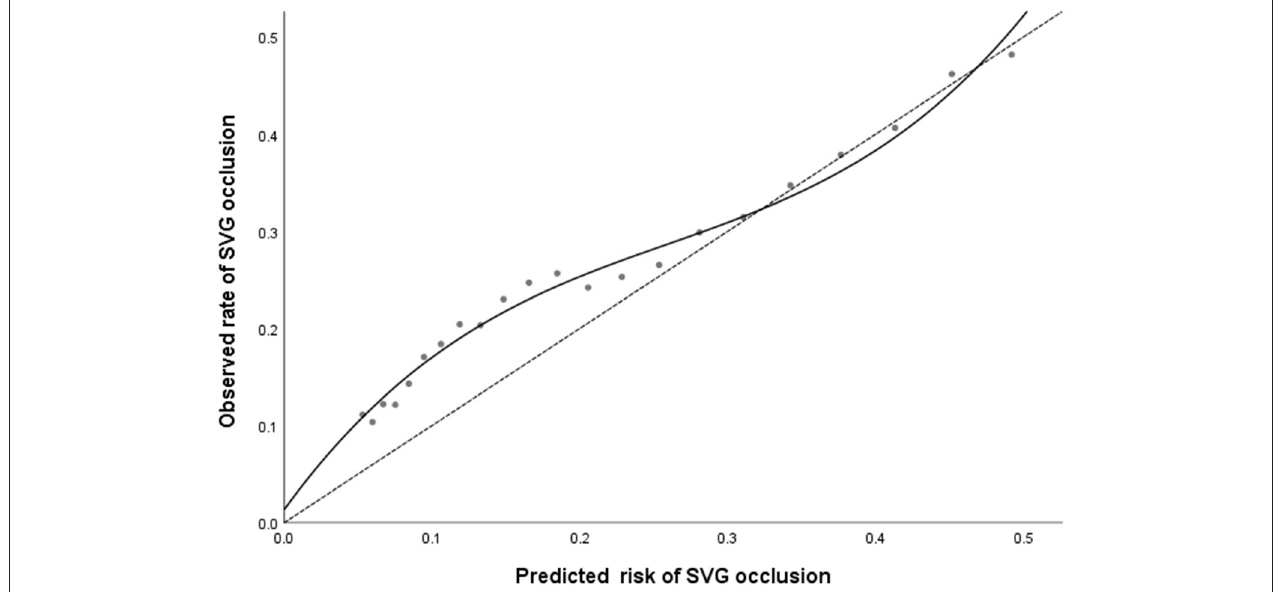
FIGURE 3 | The calibration plot presents the predicted risk against the observed proportion of late SVG occlusion for 21 groups based on the calculated SVG occlusion risk score. A locally weighted regression line is plotted to show the general trend. The dashed line is the line of reference shows the ideal calibration line. SVG, saphenous vein